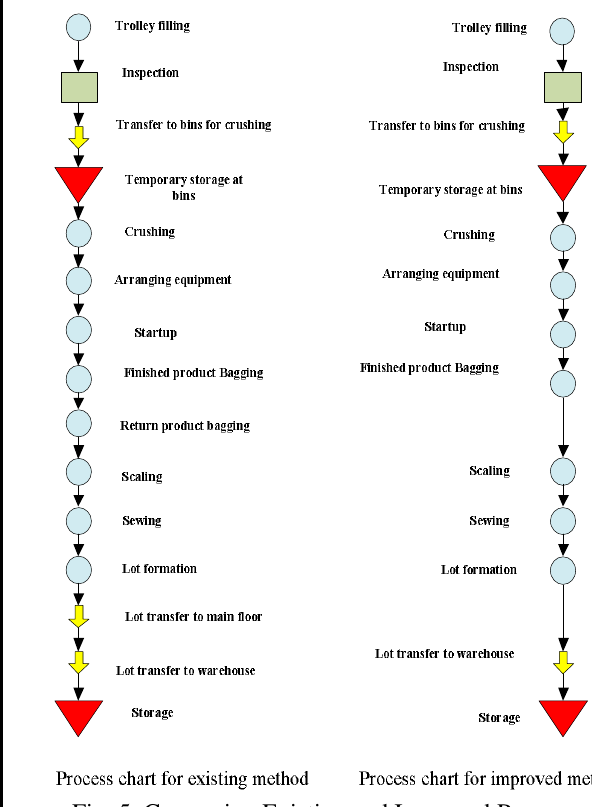
Fig. 5: Comparing Existing and Improved